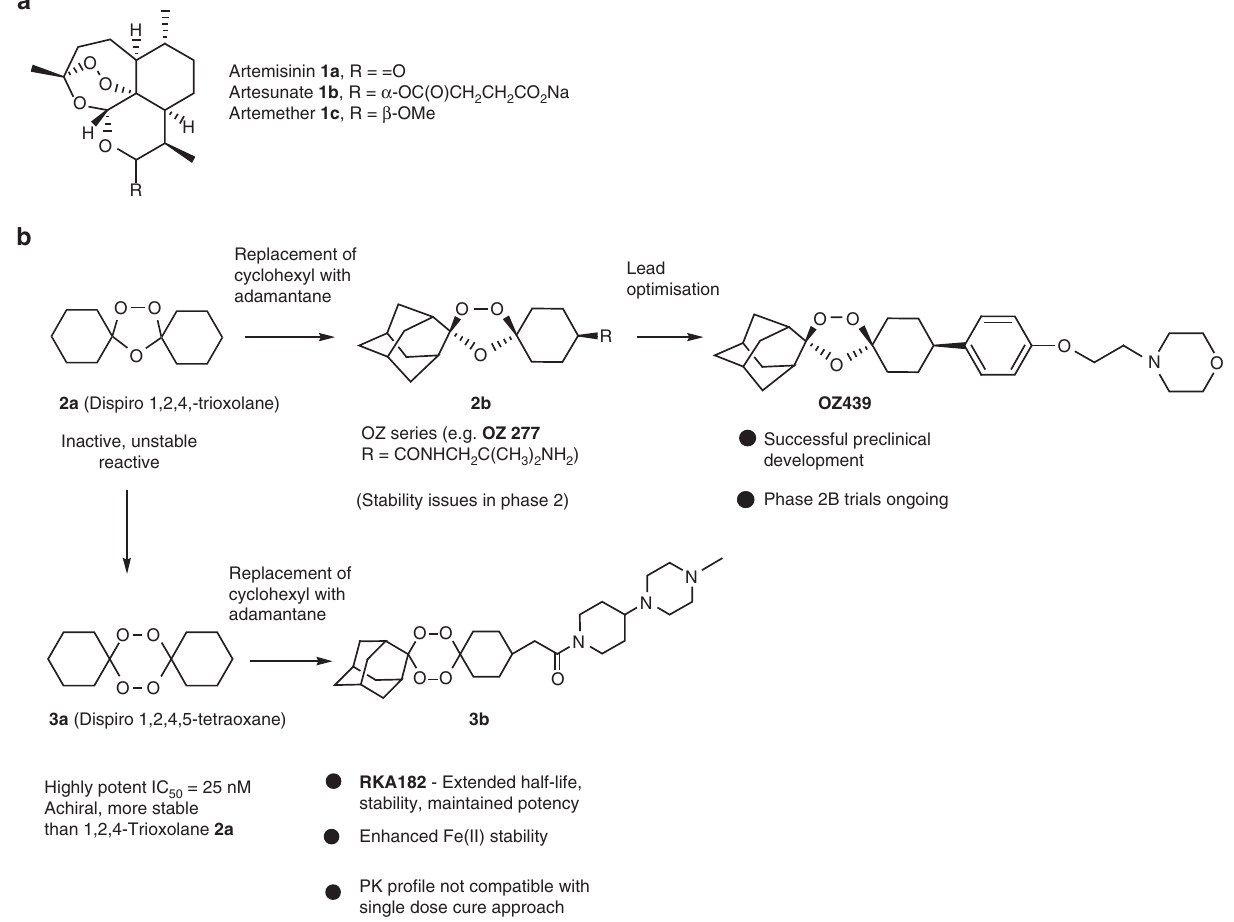
Figure 1 | Artemisinins and synthetic peroxides. ( a ) Artemisinin and semi-synthetic analogues. ( b ) Comparison of tetraoxanes with trioxolane-based anti-malarials. MSD in days following a single oral dose of 30mgkg (cid:3) 1 , Pf SCID (NOD-SCID IL-2R g c null (NSG) mice engrafted with human erythrocytes and infected with P. falciparum strain 3D7 0087/N9 E209 (10 (cid:2) IC 50 ) displayed fast killing kinetics (Supplementary Methods), with an in vitro parasite reduction ratio (log 10 PRR) 4 4.8 similar to artemisinin (log 4 4.8), and faster than CQ 10 PRR (log 10 PRR 4.5), pyrimethamine (log 10 PRR 3.7) and atovaquone (log 10 PRR 2.9) (Fig. 2) 20 .